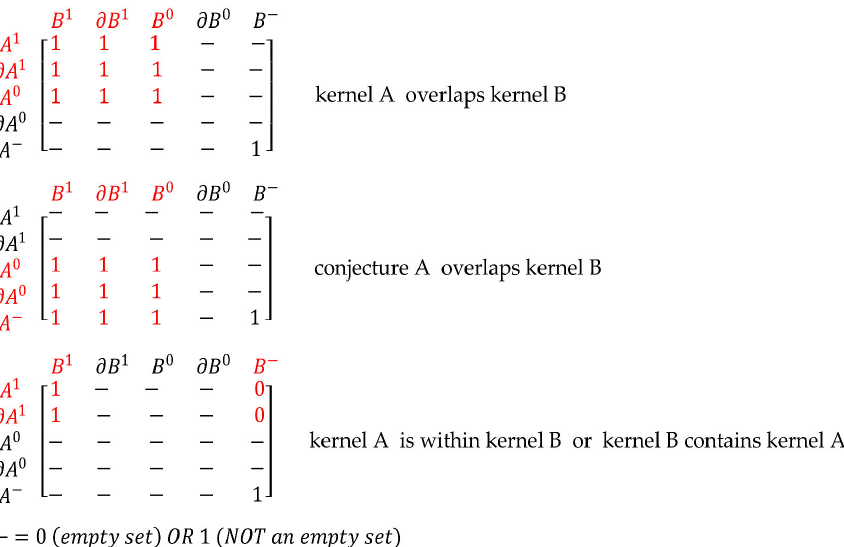
Figure 6. Illustration of three cases of fuzzy spatial relations between topological parts of A and B sensed phenomena, inferred from I 5 × 5 M